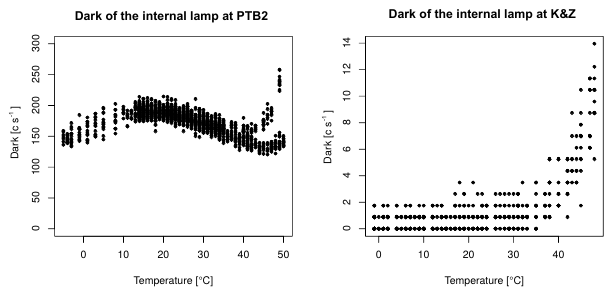
Figure 10. Dark signal values during the PTB2 and the K&Z exper-